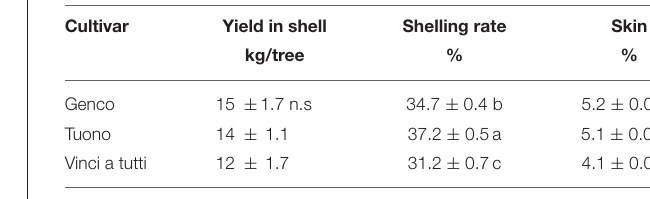
TABLE 1 | Yield, shelling rate, and skin percentage in three Italian almond